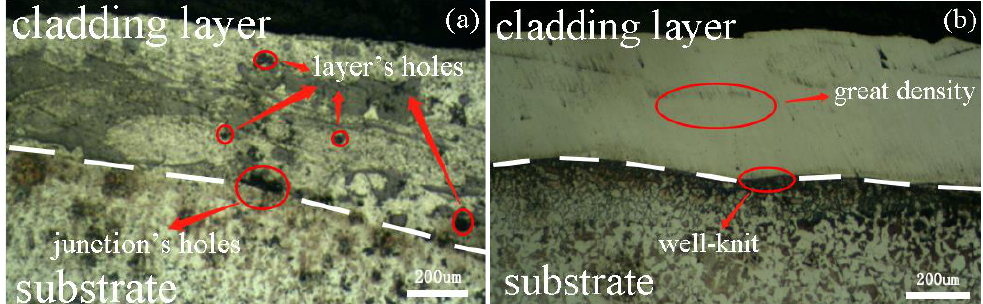
Figure 4. ( a ) A profile of amorphous powder cladding layer. ( b ) A profile of crystalline powder cladding layer.